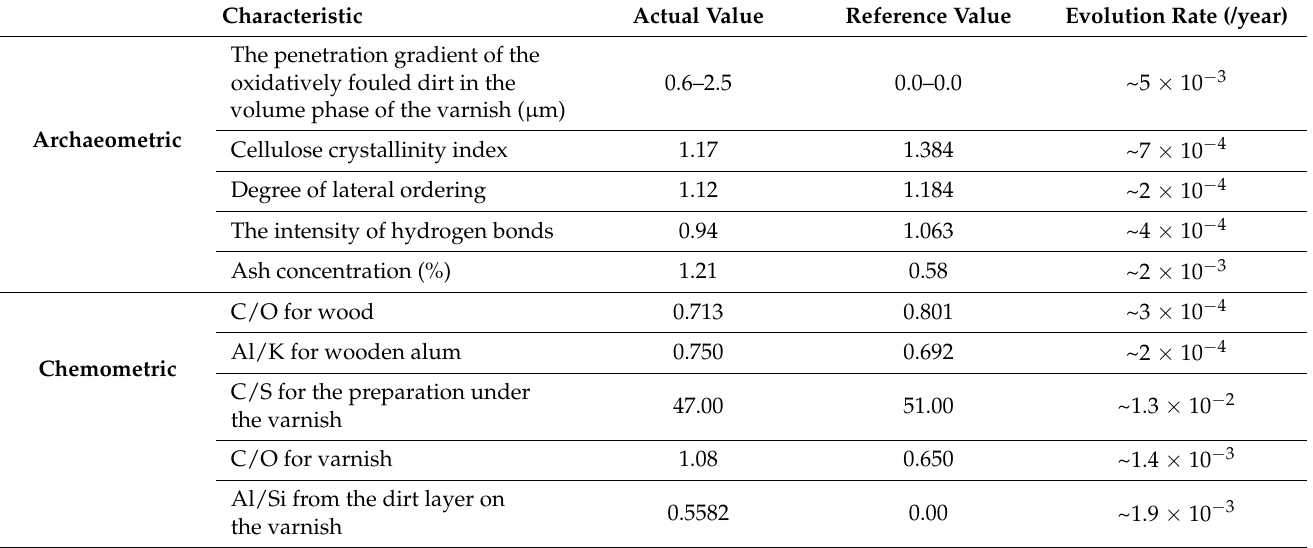
Table 2. Archaeometric and chemometric data for the wood